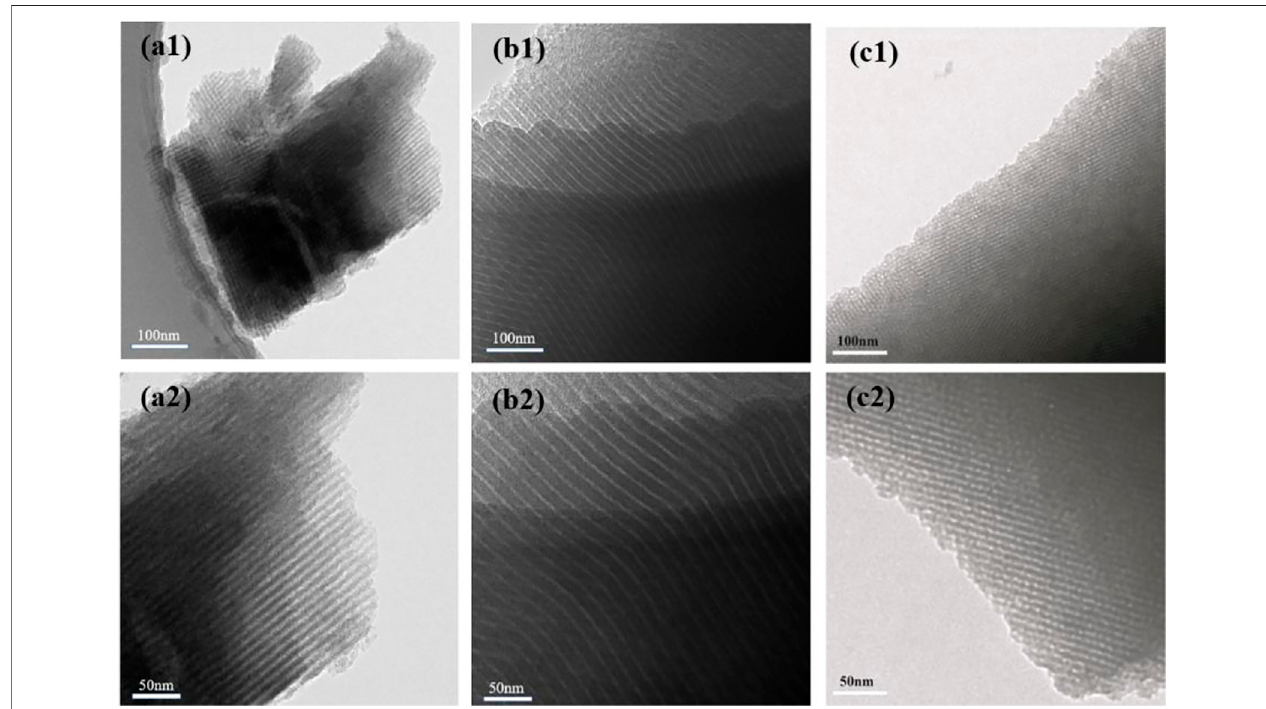
FIGURE 3 | TEM images of HPCs synthesized via HISA method in (a1 and a2) P123 (b1 and b2) F108, and (c1 and c2) CTAB/ethanol micelle system.